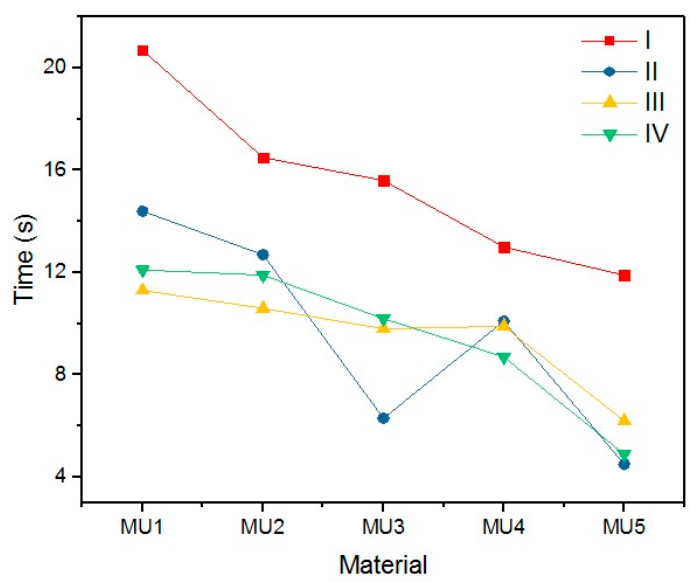
Figure 25. Time of the shape recovery process for materials programmed at different temperatures (I and II, 60 °C; III, 80 °C; and IV, 90 °C) and with different rest temperature (I, 20 °C; and II–IV, 4 °C).